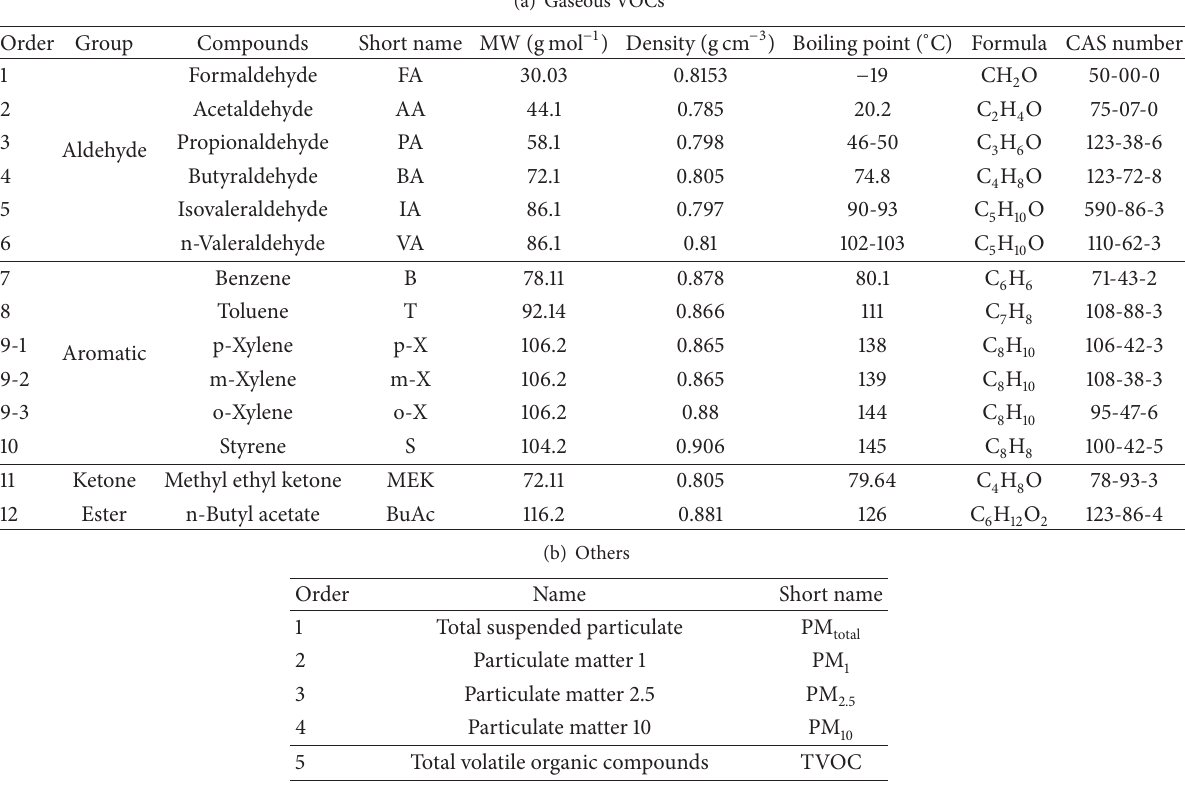
Table 1: Physicochemical properties of the target compounds investigated in this study. (a) Gaseous